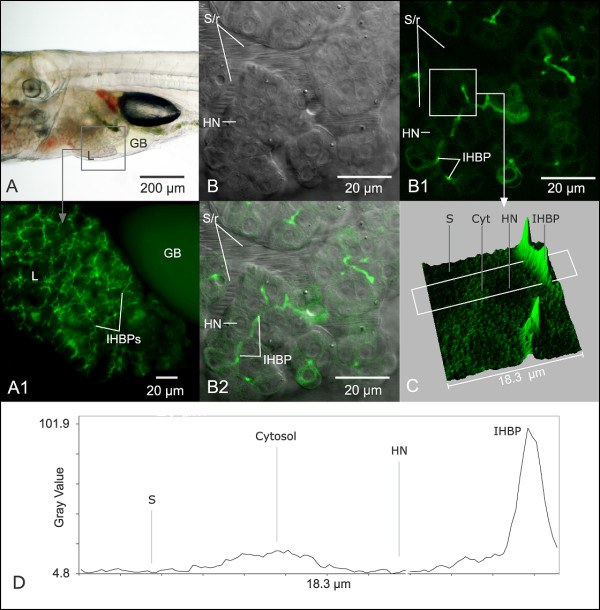
In vivo imaging of hepatobiliary transport. Fluorophores such as β-Bodipy C5 phosphocholine, shown here, enabled in vivo elucidation of the biliary system and quantitation of blood to bile transport. (A) Brightfield microscopy of STII medaka at 30 dpf. Green algae can be seen in transport through lumen of the gut. (A1) Widefield fluorescence microscopy of region of interest indicated by gray square in A, showing β-Bodipy C5 phosphocholine fluorescence in intrahepatic biliary passageways (IHBPs) of the liver (L) and gall bladder (GB). (B) Confocal DIC microscopy, STII medaka, 9 dpf: Clearly resolved were hepatocytes and their nuclei/nucleoli. In longitudinal section 2 rows of hepatocytes characterize parenchymal architecture. Stacked ovate structures are red blood cells in circulation through the sinusoids (S/r). Red cells appear flattened due to active circulation of cells through sinusoids, and resulting distortion during imaging. (B1) Same as B: Single frame from in vivo confocal image stack capturing β-Bodipy C5 phosphocholine (green fluorescence) in transport from blood to bile, through intrahepatic biliary passageways (IHBPs) of the liver (imaged in vivo 30 minutes post fluorophore administration). (B2) Composite of frames B and B1 localizing fluorophore transport to area between apical membranes of adjacent hepatocytes, suggesting concentrative transport of the fluorophore into IHBPs. (C and D) Frame C is a surface map of region of interest (white square) in frame B1, illustrating concentrative transport of the fluorophore from sinusoidal space (S) to bile space (IHBP). (D) Quantitative evaluation of the white rectangular region of interest in frame B1, spanning an 18.3 μm area from blood to bile (sinusoid to canaliculus), suggested β-Bodipy C5 phosphocholine concentration (fluorescence intensity) to be ~20 times greater in the canalicular (IHBP) vs. sinusoidal spaces (S). Also evident is an increase in cytosolic concentration of the fluorophore, while no fluorescence was detected in the nucleus. These types of studies demonstrated concentrative transport of fluorescent probes from blood to bile can be imaged and quantitatively assessed in vivo. Confocal images captured with C-apochromatic objective, 1.2 NA w/correction, 488 nm excitation, Zeiss LSM 510. Field size: 76.8 × 76.8 μm.